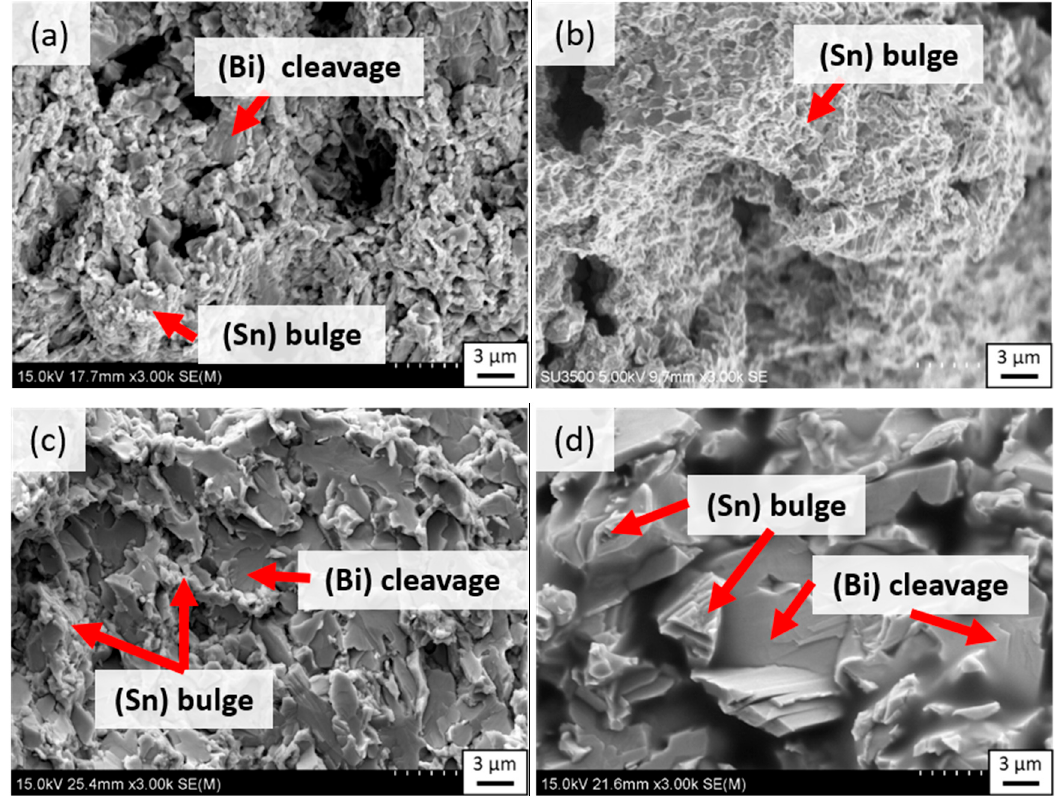
Figure 9. Fracture surfaces of ( a ) as-cast SBIG, ( b ) as-cast Sn–58Bi, ( c ) 80 °C-annealed SBIG, and ( d ) 80 °C-annealed Sn–58Bi samples.